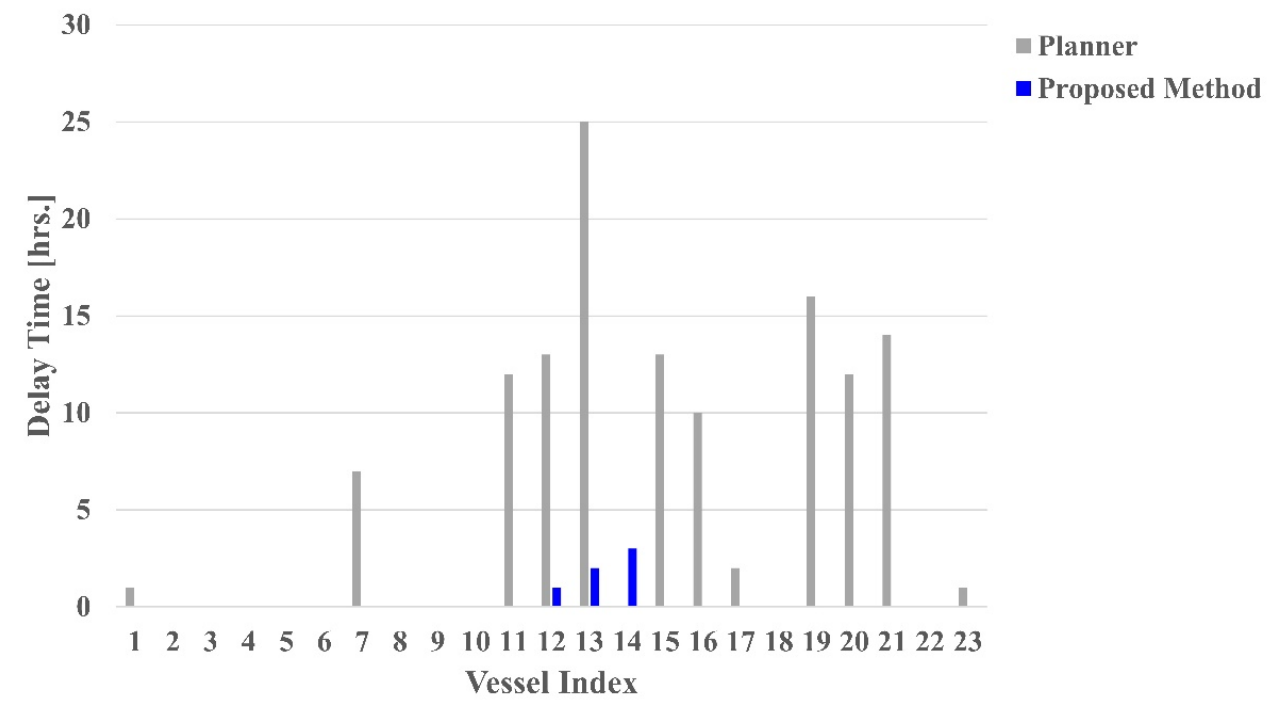
Figure 6. Departure delay time by vessel in Scenario 1.